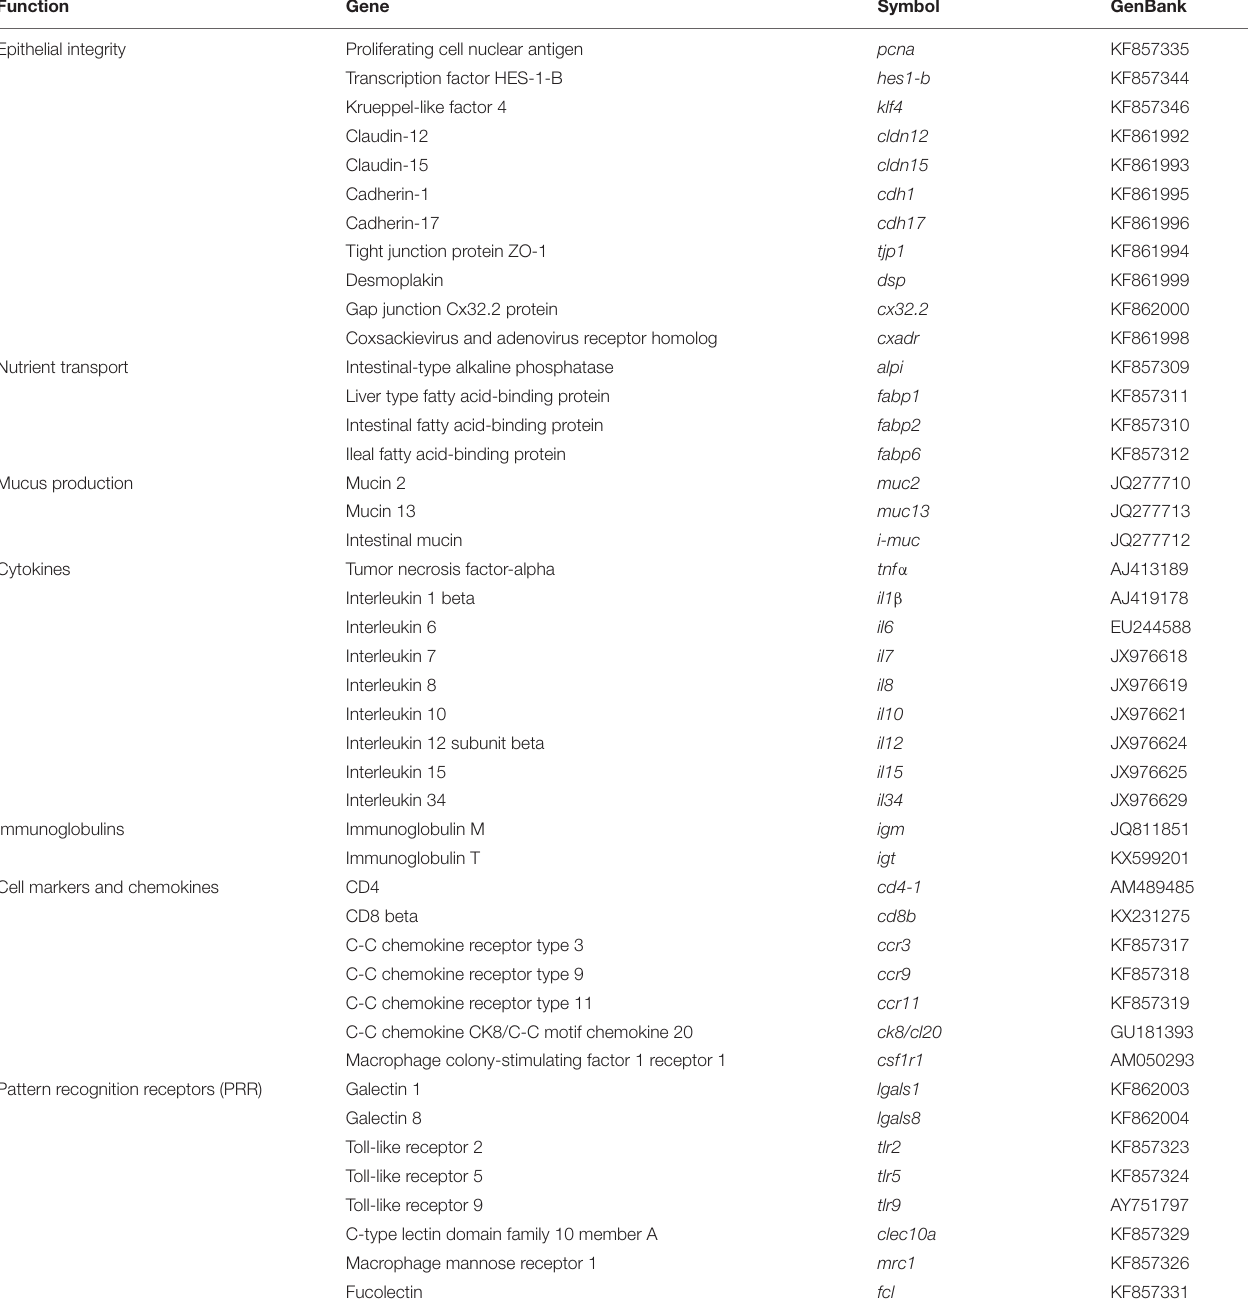
TABLE 2 | PCR-array layout for intestine gene expression profiling. Function Gene Symbol GenBank Epithelial